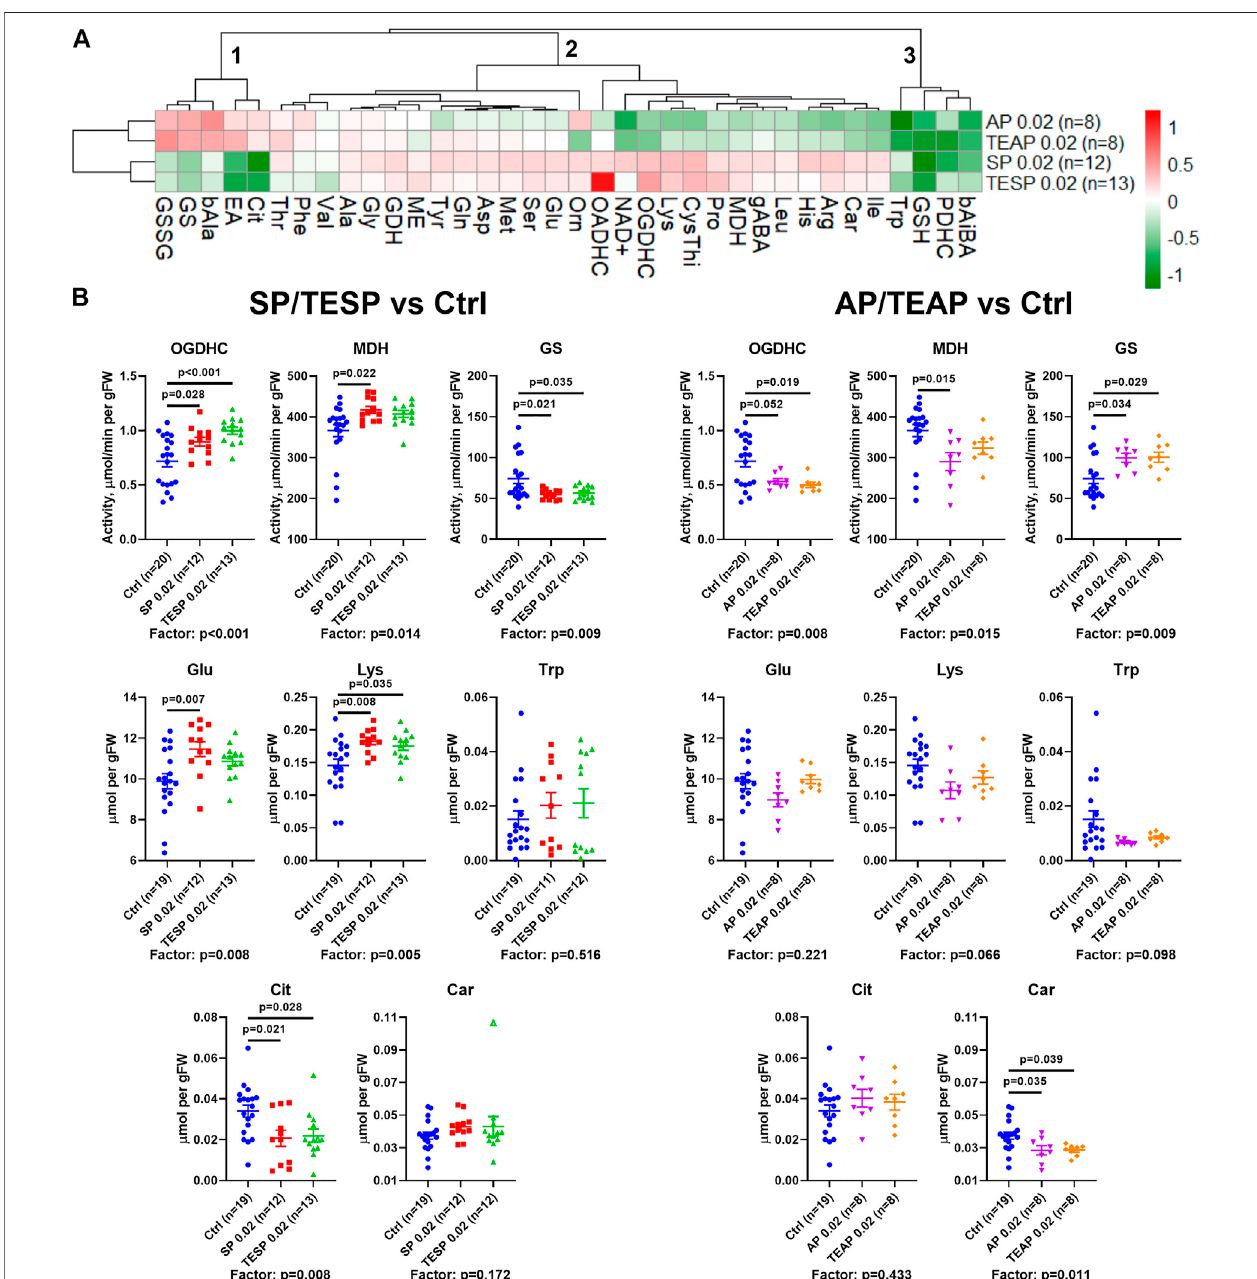
FIGURE 2 | Speci fi c effects of succinyl phosphonate (SP), adipoyl phosphonate (AP), and their triethyl esters (TESP and TEAP, respectively) on biochemical indicators of the OGDH and OADH inhibition in the rat cerebral cortex. All the inhibitors are administered at 0.02 mmol per kg. (A) Heatmap of the treatment-induced changes in the levels of metabolites and enzyme activities, presented as log2 of the fold-change from their average levels in the non-treated animals. (B) Changes in the absolute values of selected indicators of the OGDH and OADH inhibition after administration of SP/TESP or AP/TEAP, compared to the control values. Signi fi cant ( p ≤ 0.05) differences between the experimental groups, estimated by ANOVA with Tukey ’ s post hoc test, are indicated as exact p -values on the graphs. ANOVA signi fi cances of the treatment factor are shown below the graphs. The hollow symbol corresponds to an outlier excluded according to the iterative Grubb ’ s test. The numberofanimalsinexperimentalgroups( n )isindicatedincludingoutliers.Proteinogenicaminoacidsareabbreviatedaccordingtothestandardthree-lettercode.Other abbreviations are given in the Glossary section.